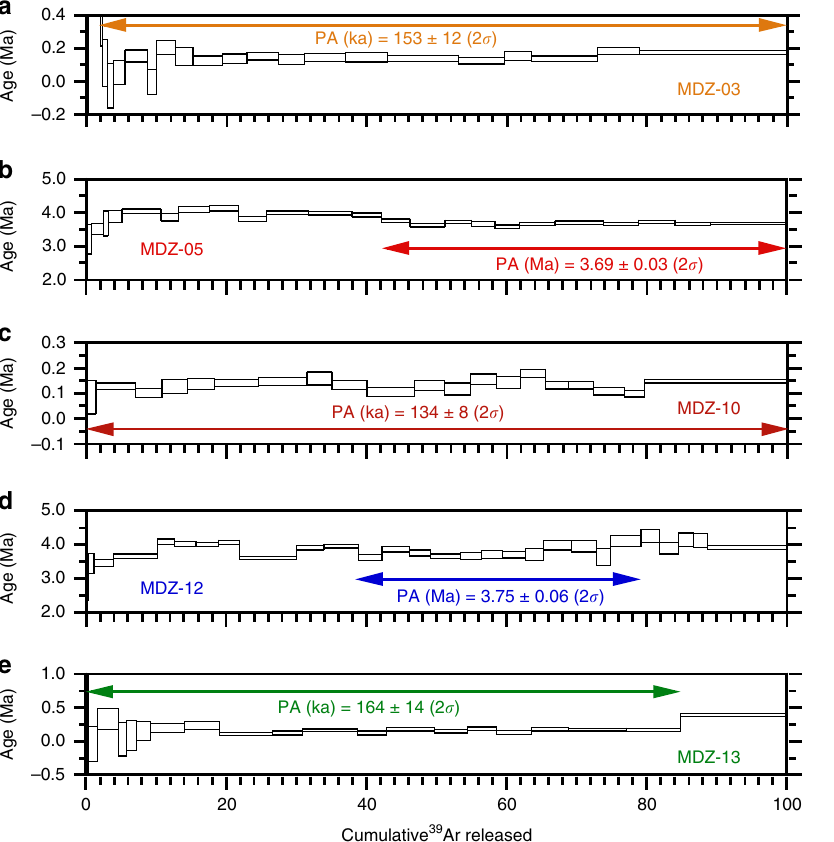
Fig. 4 Ar/Ar analysis. Graphs illustrating the Ar/Ar data of samples MDZ03 ( a ), MDZ05 ( b ), MDZ10 ( c ), MDZ12 ( d ), and MDZ13 ( e ), reporting Plateau Age (PA) with the respective estimated error. Arrows span consecutive steps included in the plateau ages. Boxes represent the heating-steps, with the width of the box representing the percentage of 39 Ar released and its thickness corresponding to the analytical error (lower and upper limits of the uncertainty at ±1 σ )